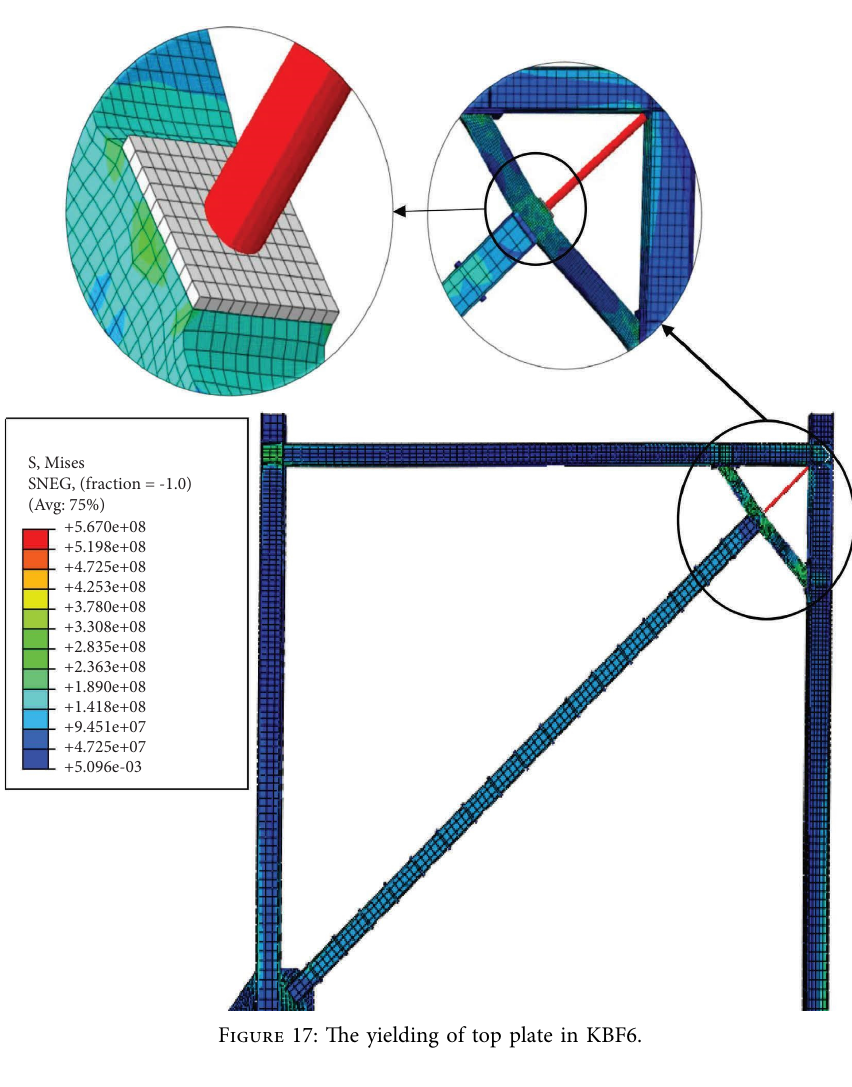
Figure 17: Te yielding of top plate in KBF6.